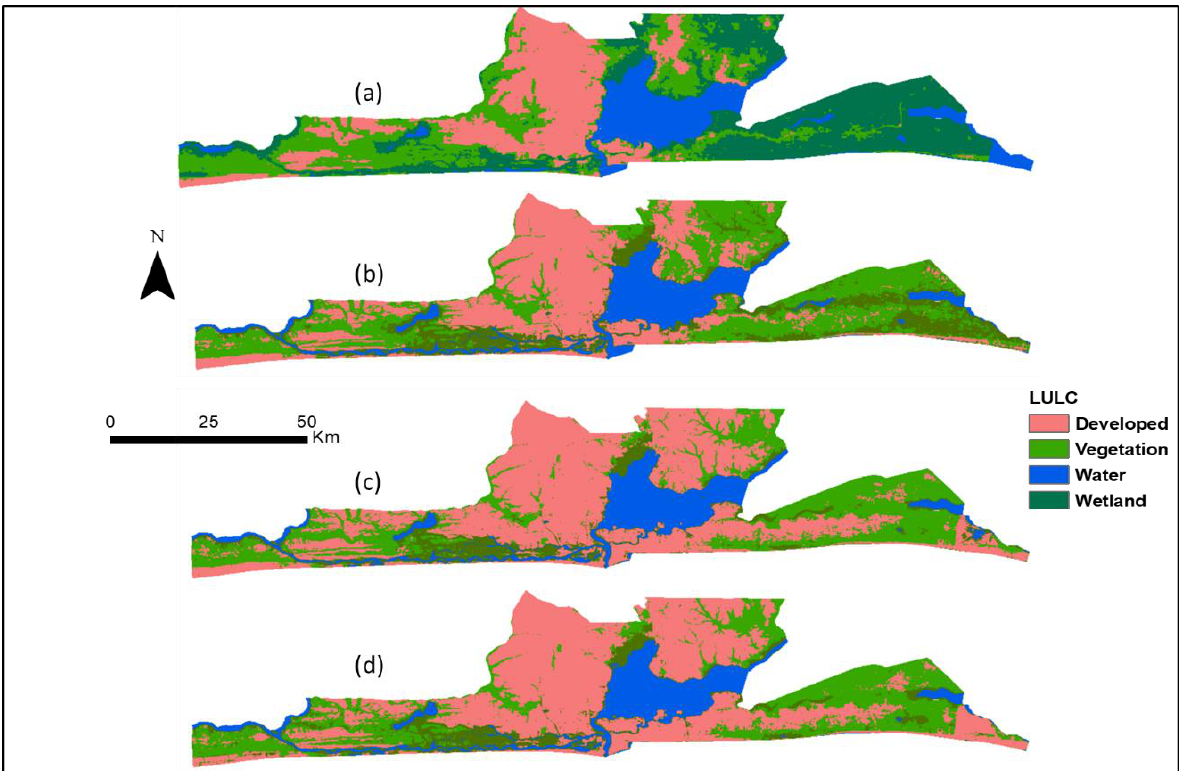
Figure 4. LULC classification maps for ( a ) 1986, ( b ) 2000, ( c ) 2016, and ( d ) 2020 for the State of Lagos, Nigeria.